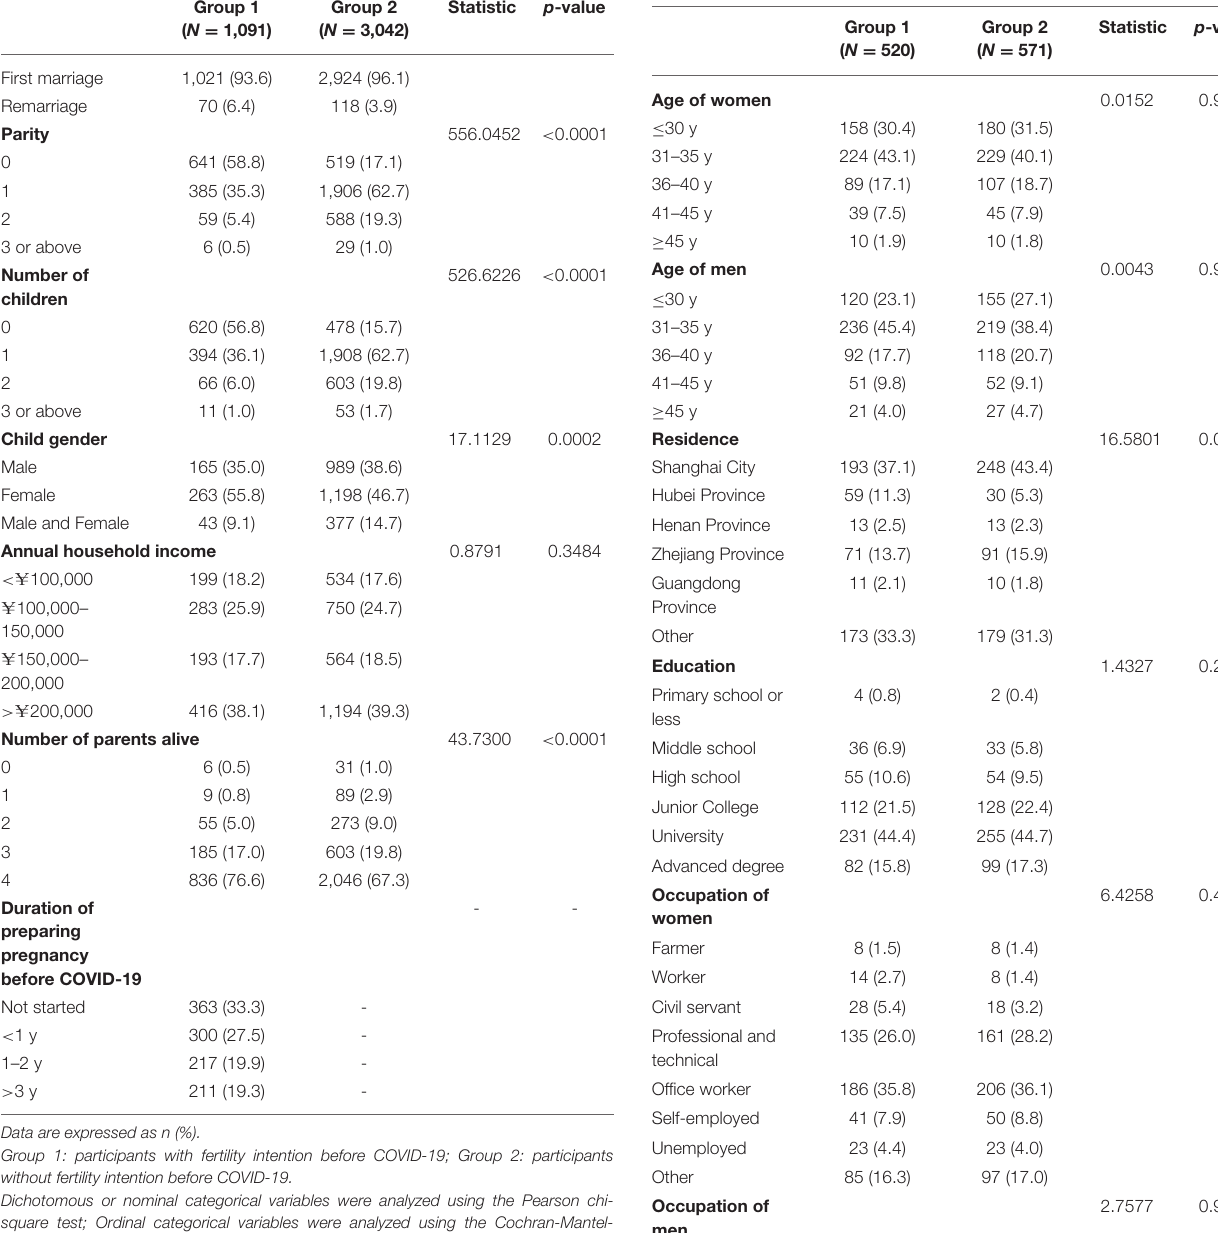
TABLE 2 | Basic information of 1,091 respondents with fertility intention before